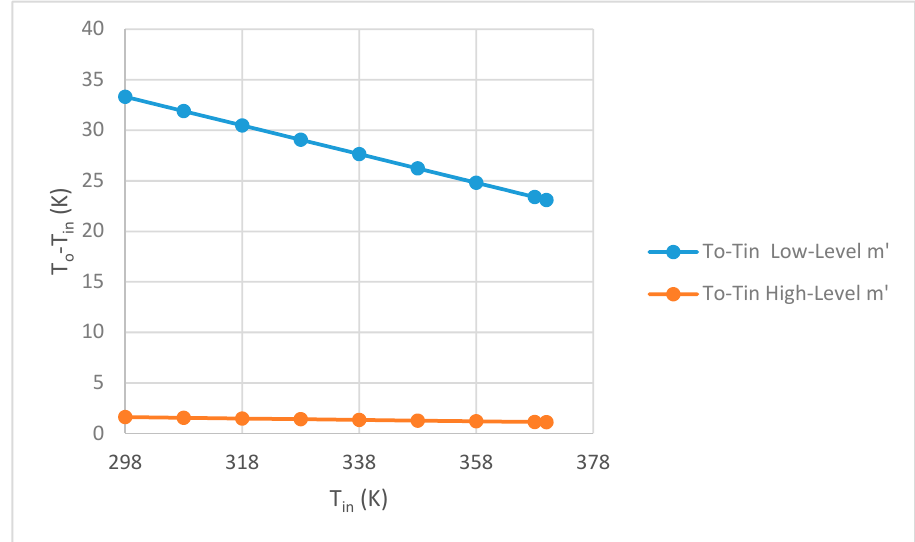
Figure 13. Effect of flowrate on T o − T in at two levels flowrate.